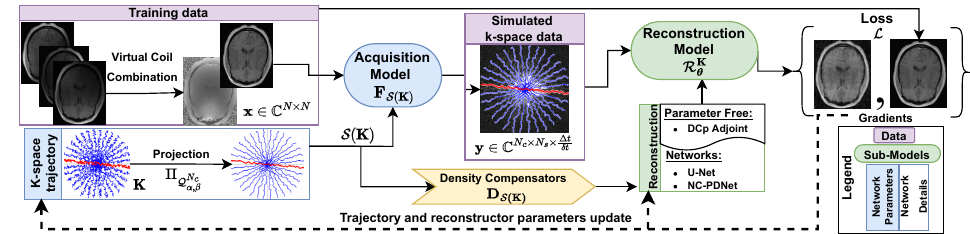
Figure 1. A generic learning-based framework for joint optimization of the MRI acquisition and reconstruction models. This framework consists of two sub-models: (1) the acquisition model F S ( K ) parameterized by the k-space sampling trajectories K and interpolated through linear interpolation S ( K ) , and (2) the reconstruction model R K parameterized by θ . The input training data consists of θ emulated single coil complex images, from which simulated k-space data are obtained through F S ( K ) . The loss L is calculated between the reconstructed image and the ground truth. The gradients are backpropagated to result in a k-space trajectory and reconstructor parameters update. Projection Π is carried out after the trajectory update to make sure it satisfies the hardware constraints and Q Nc α , β lies in the constraint set Q N c . Further, the density compensator D S ( K ) of the k-space trajectory serves α , β as input to the reconstruction